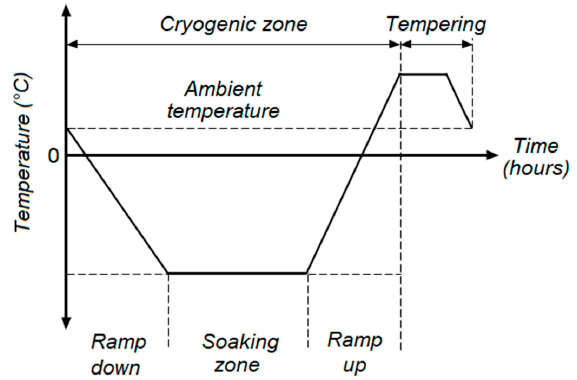
Figure 2. Deep cryogenic treatment (DCT) with single tempering.